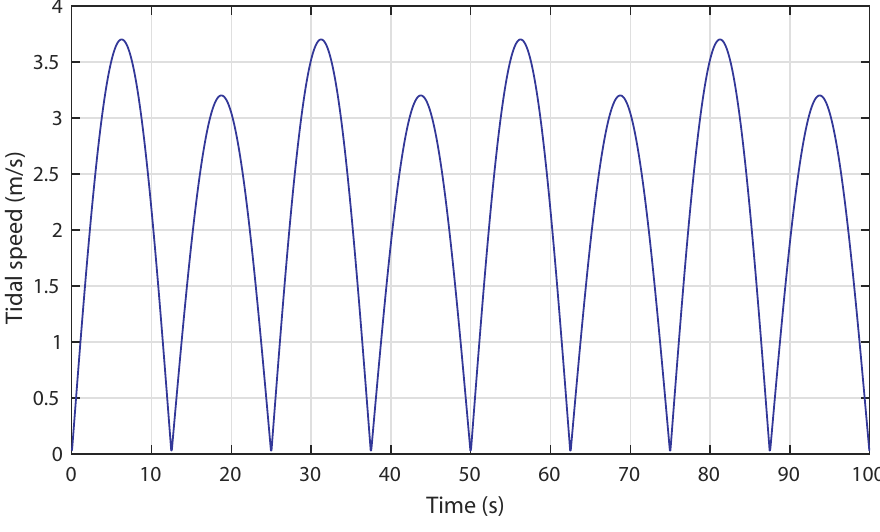
Figure 13. Scenario 1: regular tidal speed input.